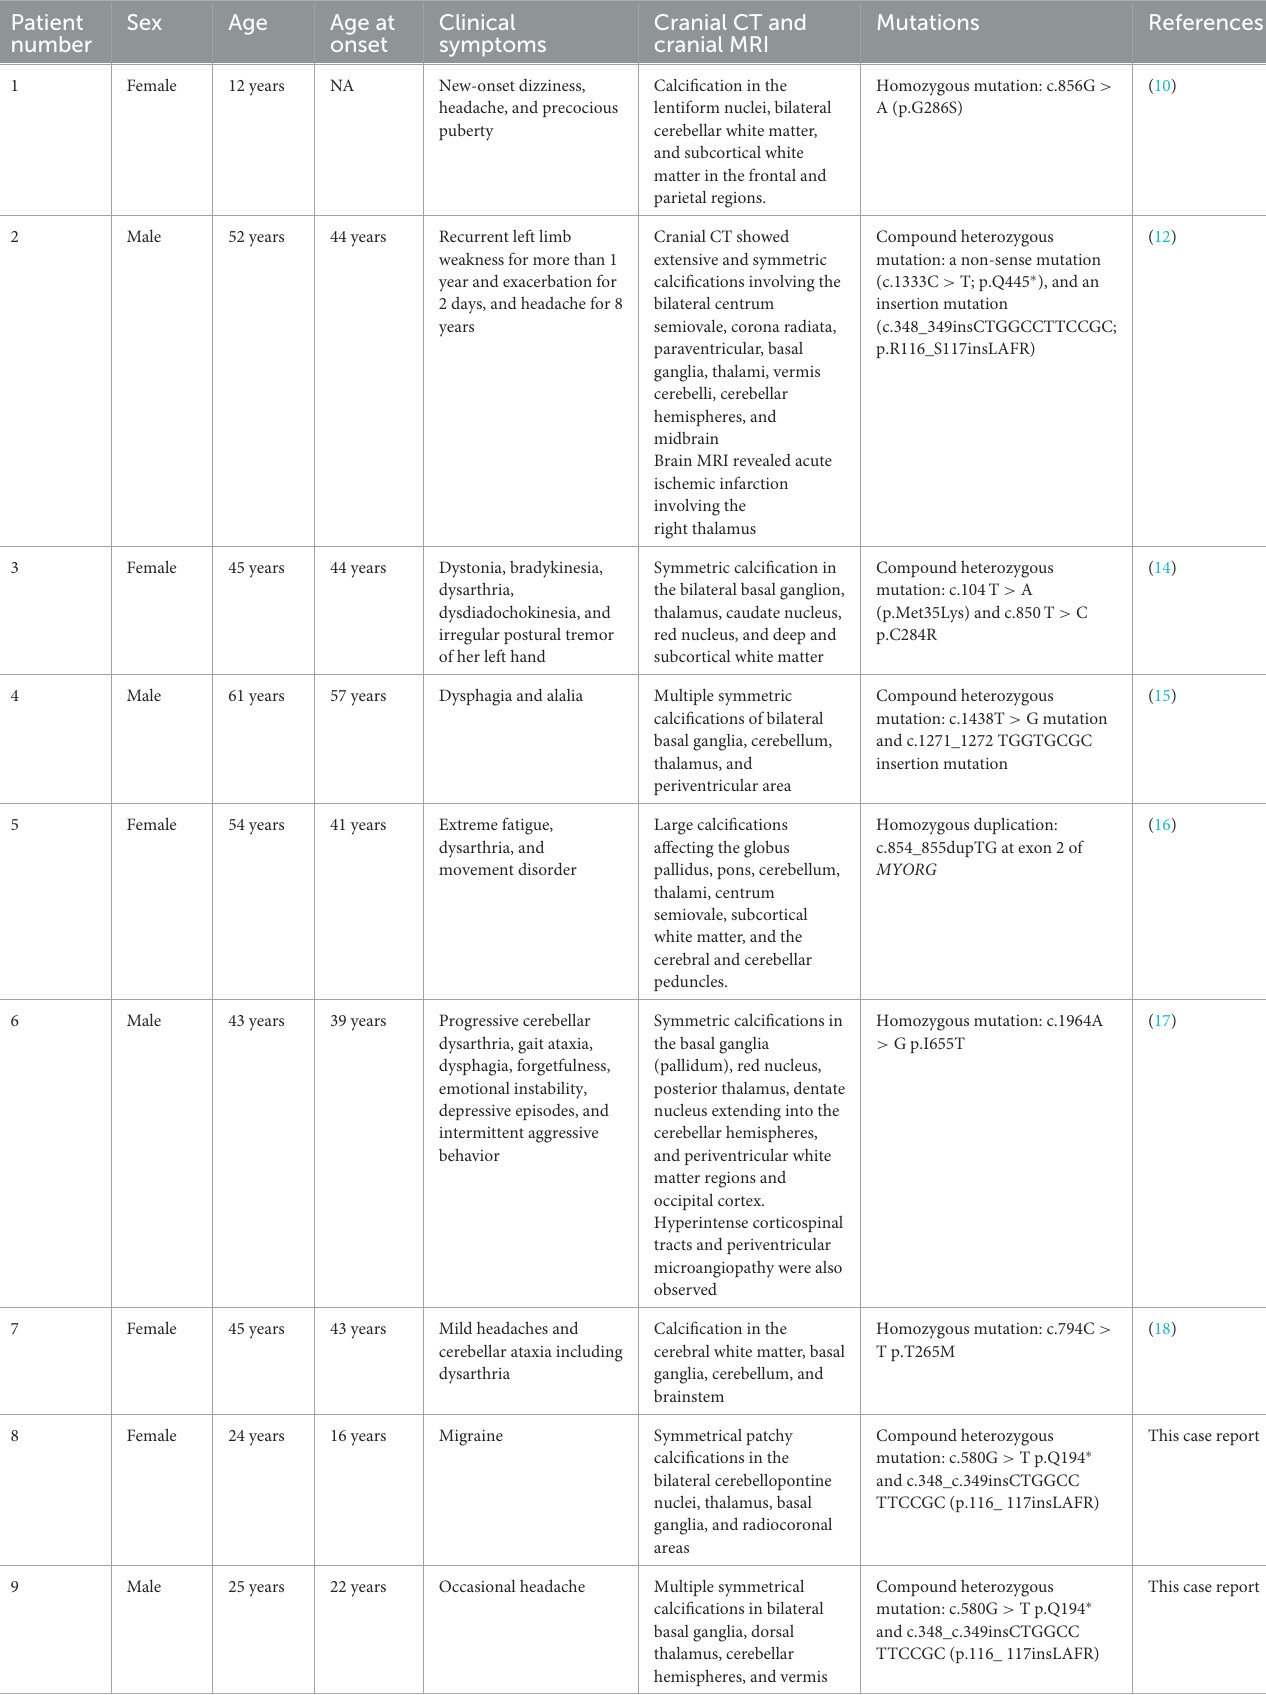
TABLE 1 Review of the previous literature related to AR-PFBC patients with MYORG mutations in comparison to the patients presented in the current report. Patient